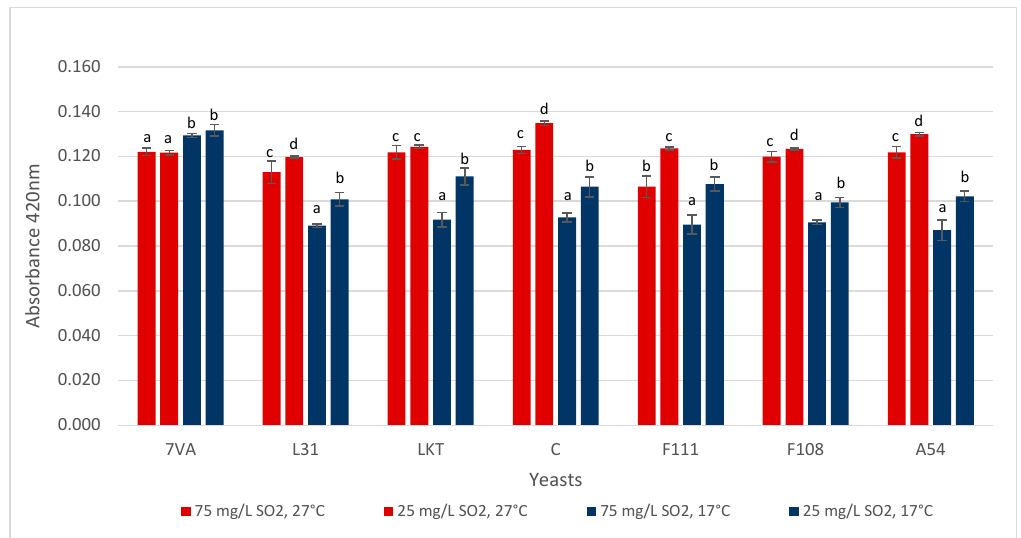
Figure 7. Absorbance at 420 nm (yellow colour) by the wine samples. Values are means ± sd ( n = 3). Different letter for the same yeast means significant differences ( p < 0.05).